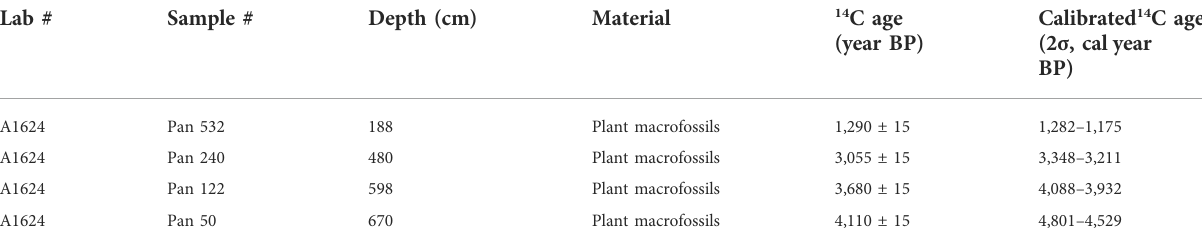
TABLE 1 AMS 14 C dates for KLA loess